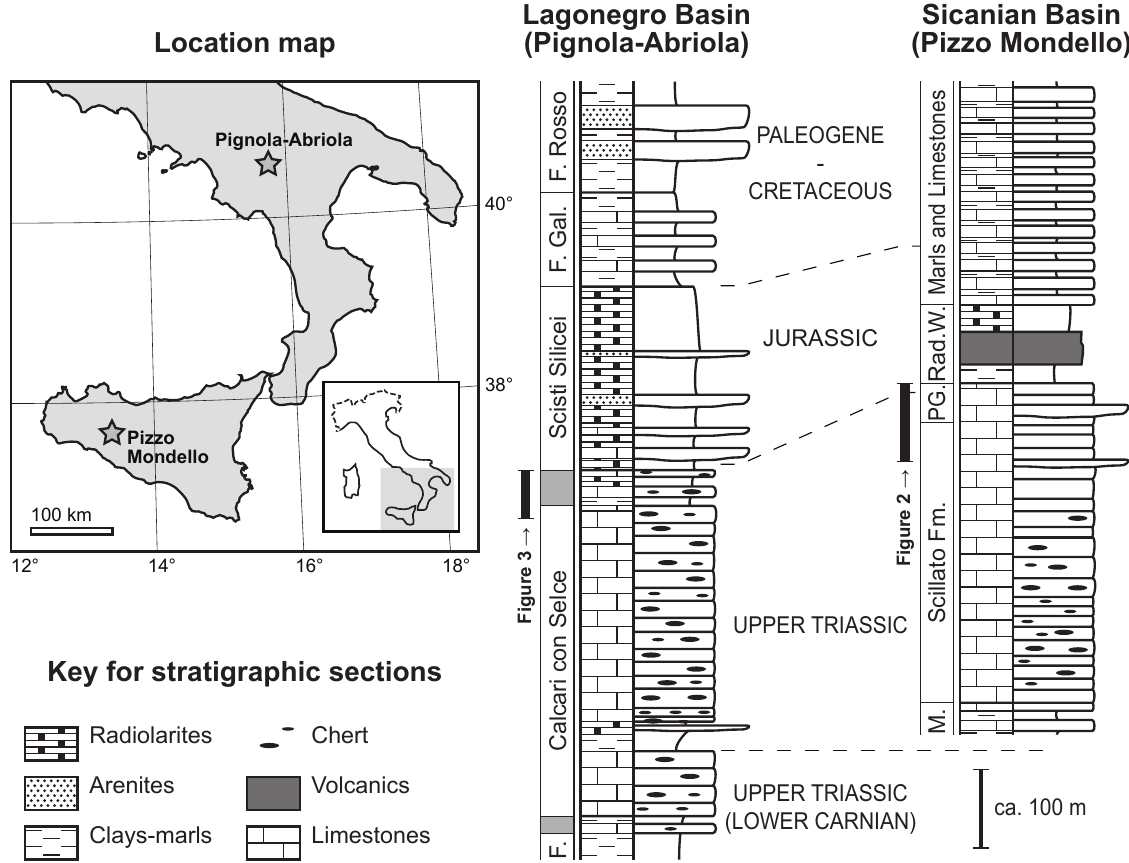
Fig. 1. Location of the studied stratigraphic sections in southern Italy, and synthetic stratigraphic succession of the Lagonegro Basin at Pignola (modified from Passeri et al., 2005) and of the Sicanian Basin at Pizzo Mondello (modified from Di Stefano et al., 1996). The scale is